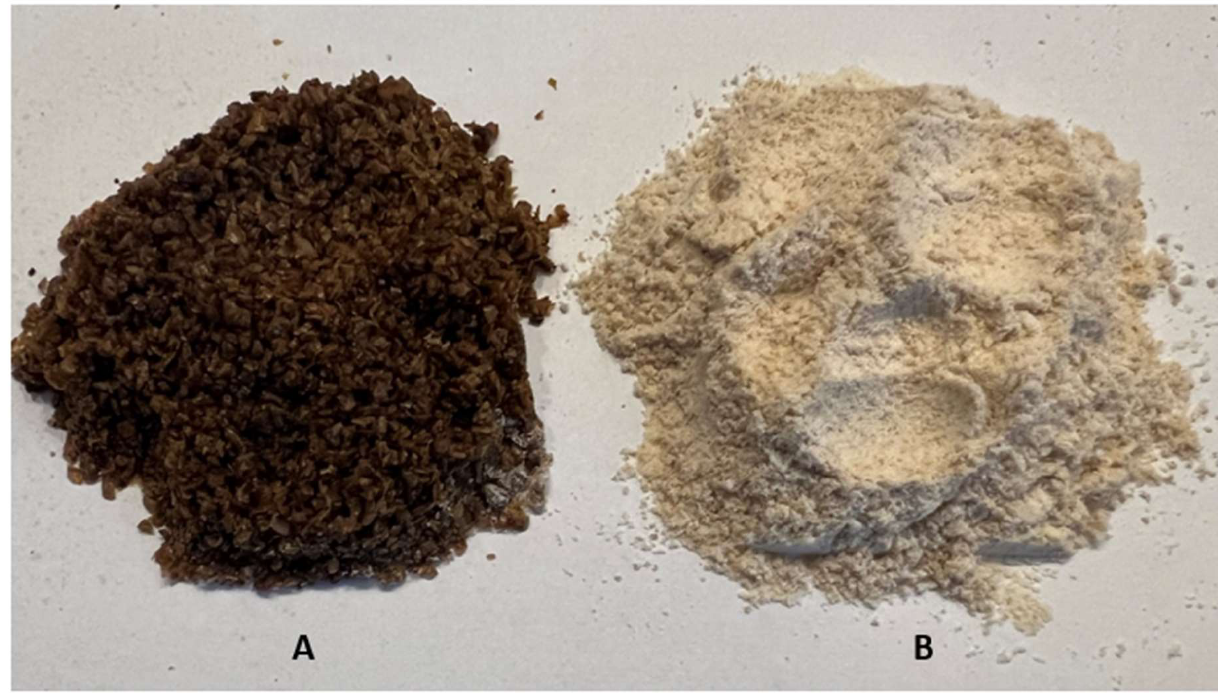
Figure 1. Pictures of the mealworm powder ( A ) and wheat flour ( B ) used for bread